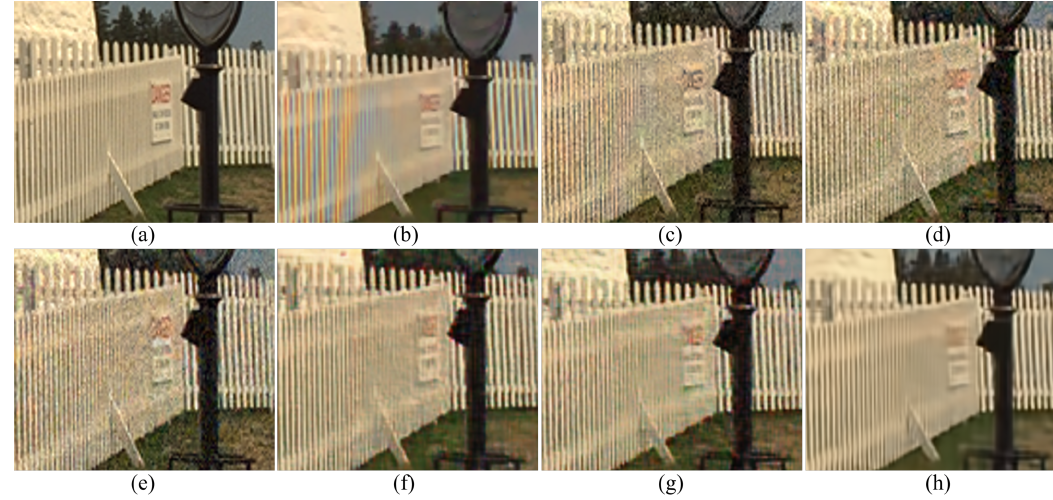
Figure 5. Enlarged regions of Figure 4. ( a ) Original, ( b ) ADMM, [28] ( c ) SEM, [14] ( d ) DNetB, [15] ( e ) DNetX, [15] ( f ) DIP, [19] ( g ) proposed and ( h ) proposed +